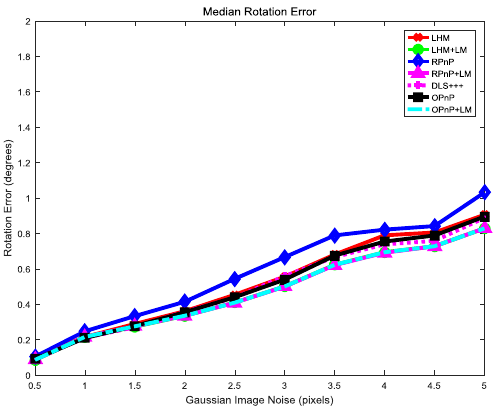
Figure 6. Median rotation error w.r.t. varying noise levels